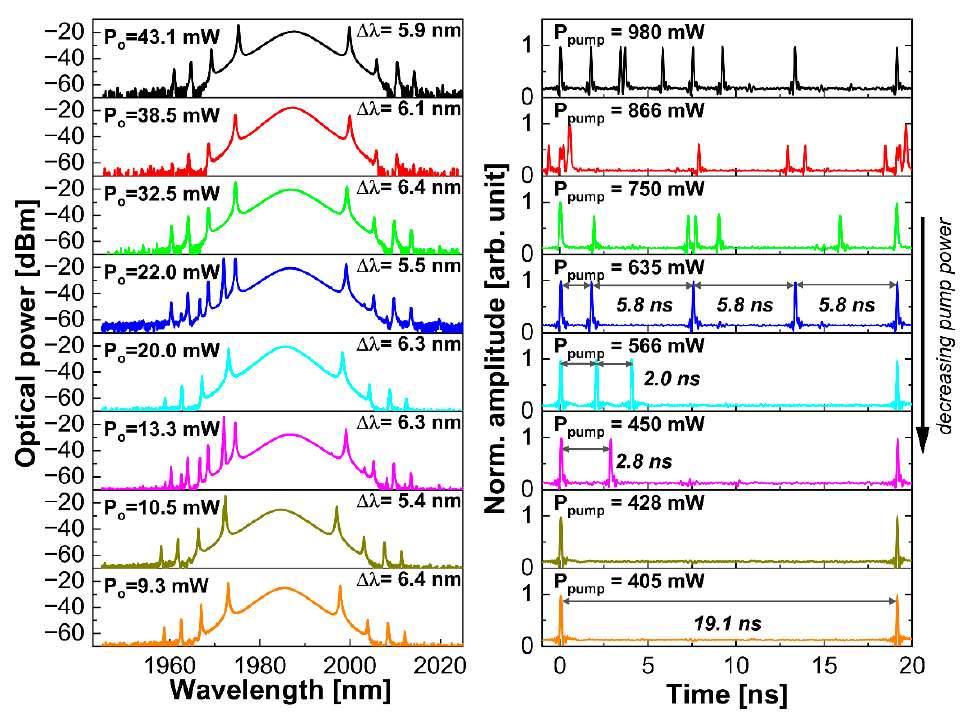
Figure 4. Optical spectra ( left ) and recorded oscillograms ( right ) for eight different laser operating states corresponding to given pumping power.